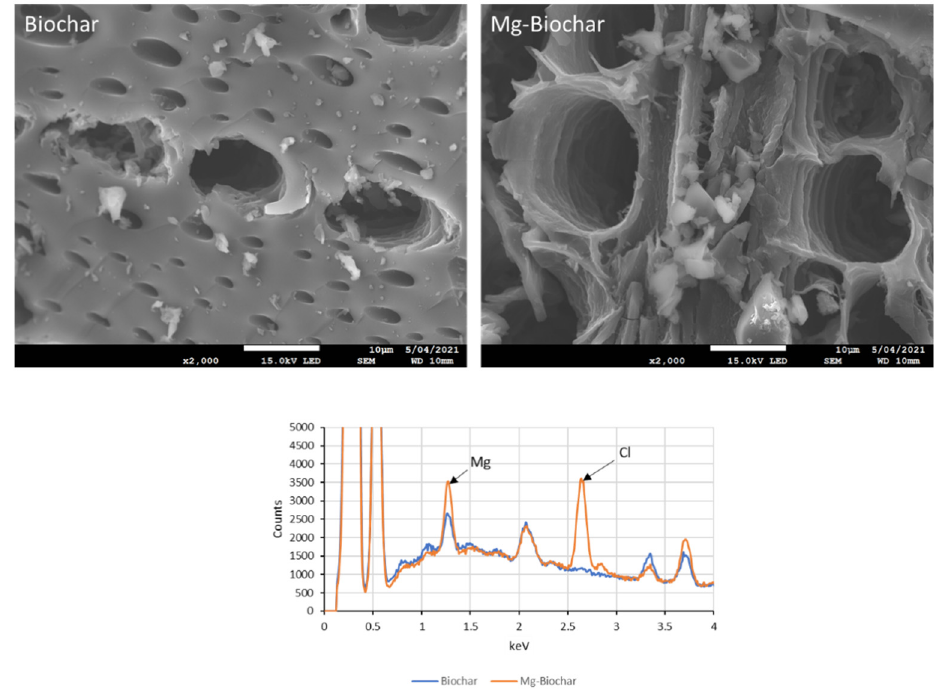
Figure 2. SEM scans and EDS spectrum of the biochar before and after modification.